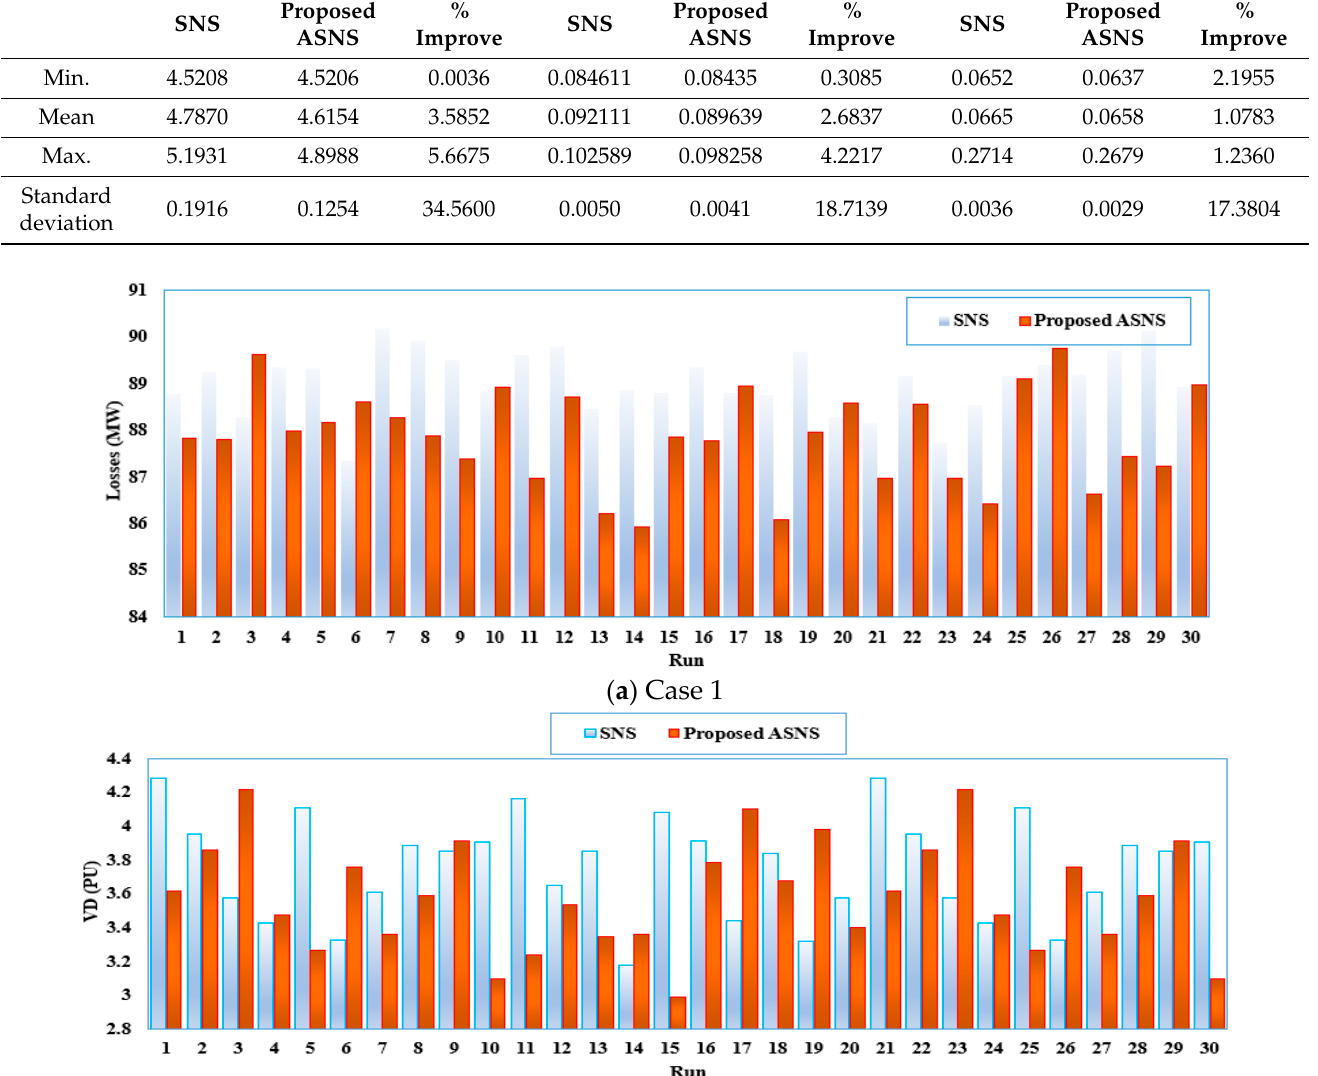
Figure 15. Box and Whiskers plot for the SNS and proposed ASNS of the IEEE 30-, IEEE 57-, and IEEE 118-bus grids. Table 14. Detailed robustness indices for Cases 1-3 of the IEEE 30-bus grid. Table 14. Detailed robustness indices for Cases 1-3 of the IEEE 30-bus grid.